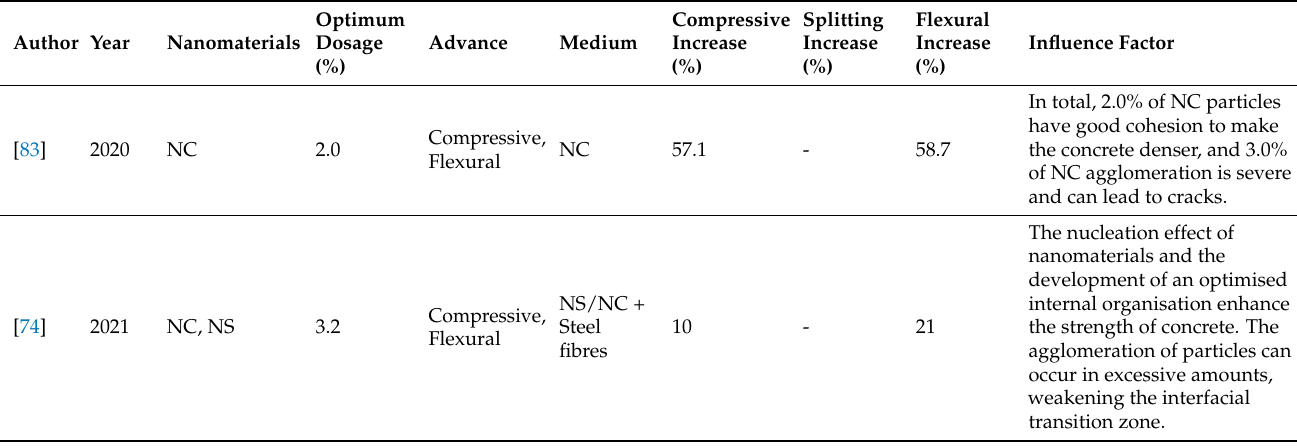
Table 1. Findings of mechanical properties of nano